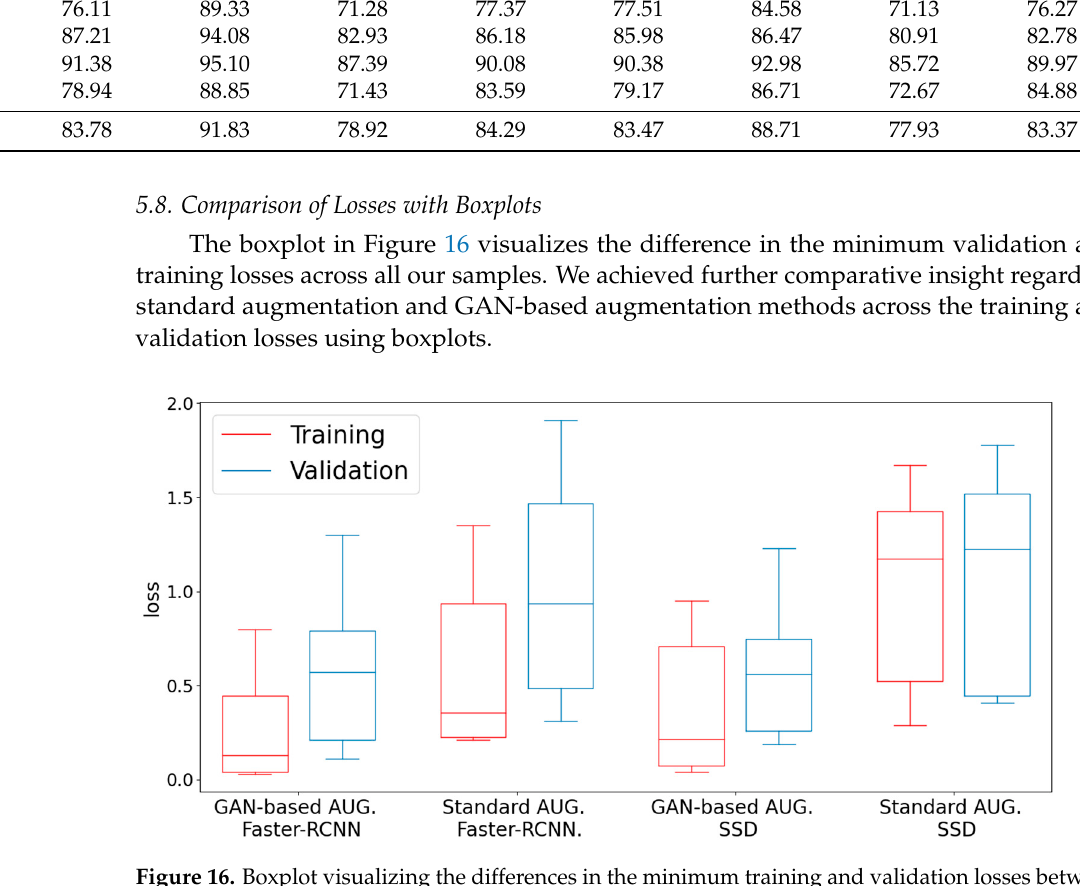
Table 5. Pairwise comparison between the minimum training and validation losses from the pro- posed augmentation pipeline and the standard augmentation method.